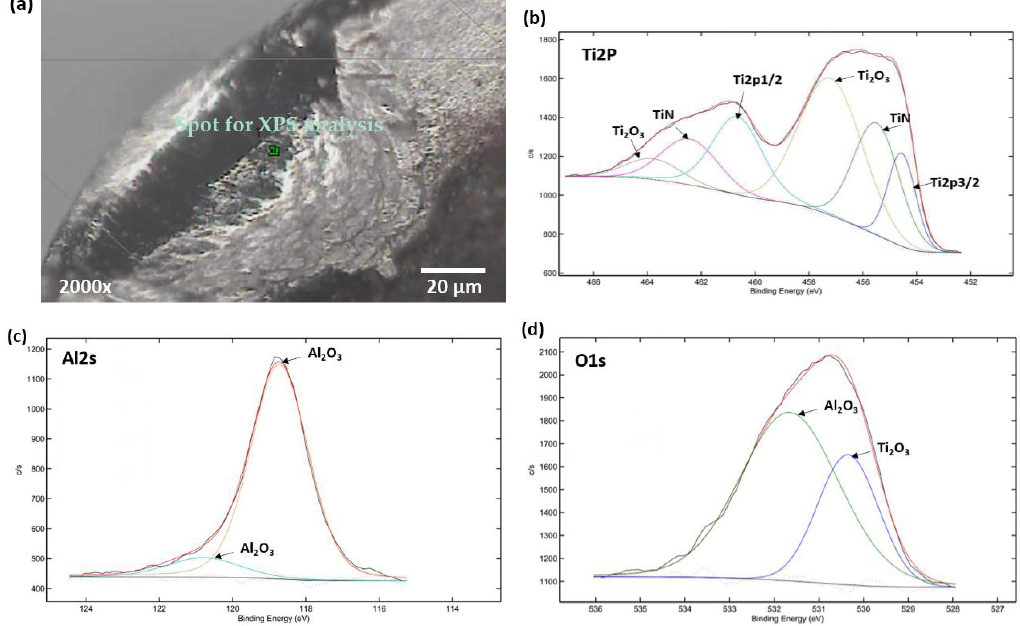
Figure 4. XPS data for tribo-films formed on the worn surface of AlTiN coating. ( a ) XPS spot on the AlTiN tool rake face; ( b ) AlTiN XPS high resolution spectra line for Ti2p; ( c ) AlTiN XPS high resolution spectra line for Al2s; and ( d ) AlTiN XPS high resolution spectra line for O1s.